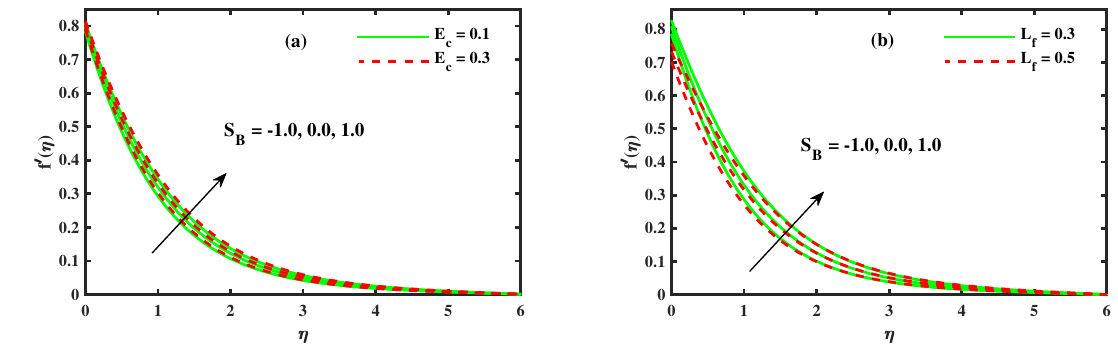
Figure 5. The impact of f (cid:48) ( η ) for ( a ) Electric current E I and ( b ) hydrodynamic slip L f .